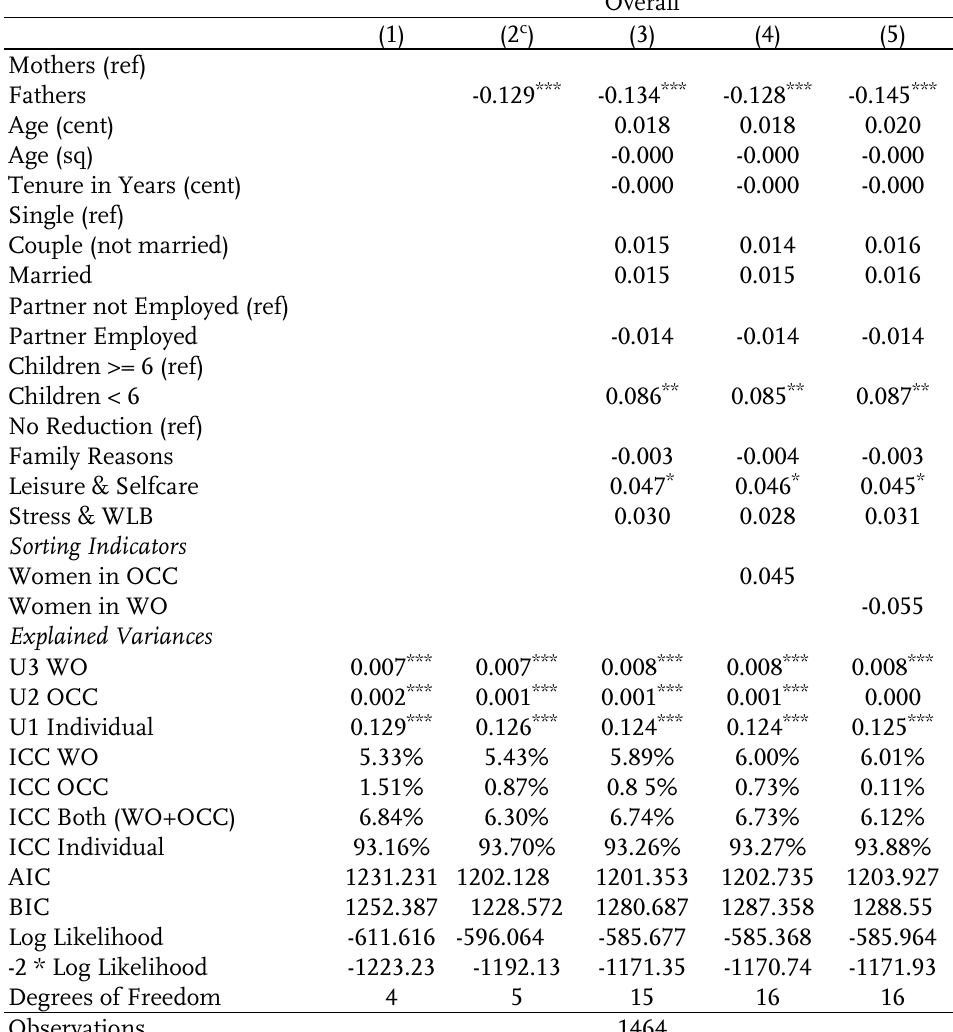
Table 3 : Cross-classified multilevel model on reduction of contracted work